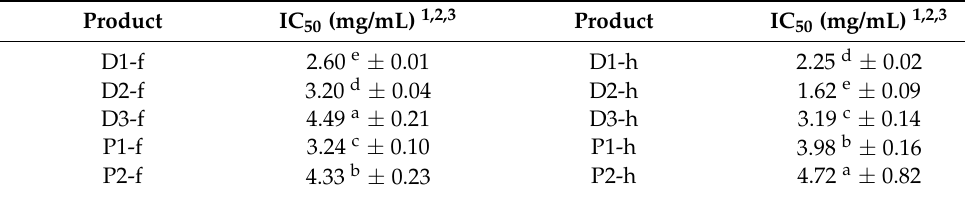
Table 7. DPPH antioxidant activity of fruit and husk extracts from P. peruviana